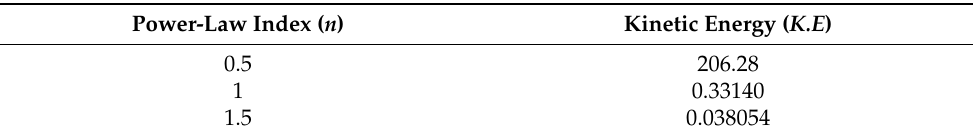
Table 3. Variation in Nusselt number ( Nu ) and kinetic energy at different values of Rayleigh number ( Ra